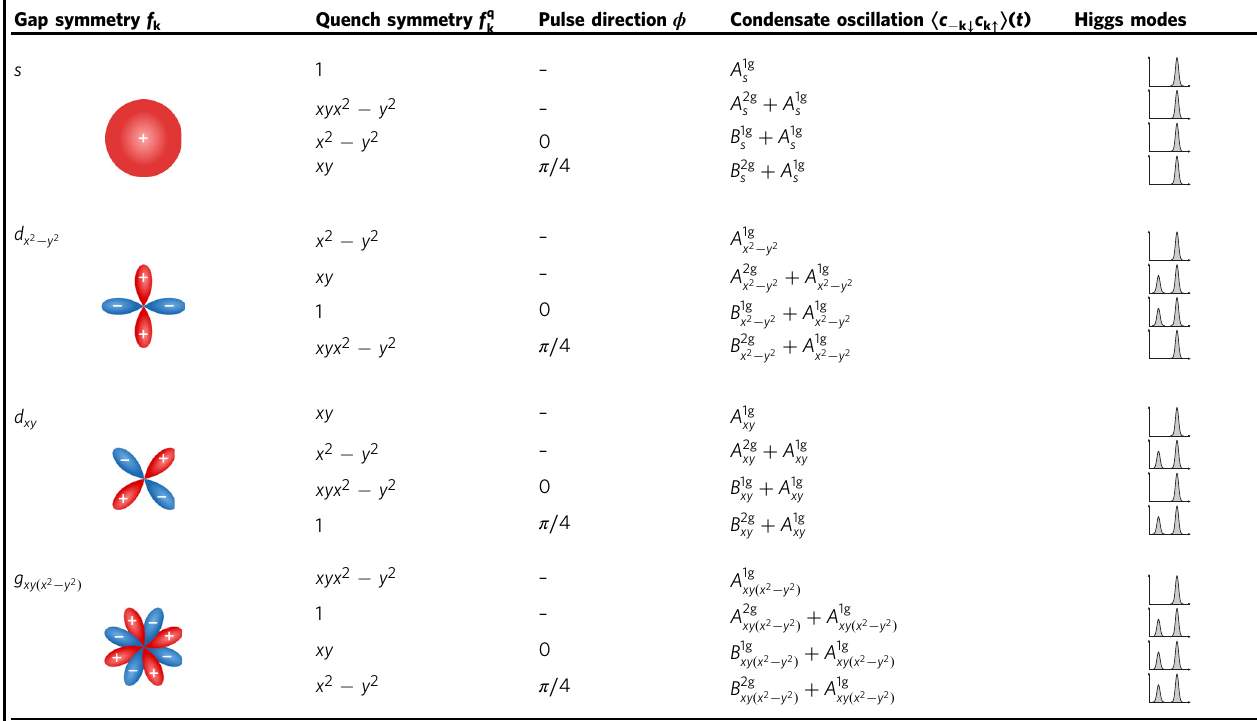
A quench can be applied tothe condensate witha certain symmetry f q k (column two), whichdisturbs the ground state condensate symmetry. These quenches canbe controlledby an incident THz pulse with angle ϕ . Pumping at an arbitrary angle corresponds to a quench in all symmetry channels. Choosing high symmetry direction (column three) allows for a selective excitation. Such a quench excites oscillations of the condensate (column four), classi fi ed by the notation of the irreducible representations of the lattice symmetry. Oscillations of the condensate lead to amplitude oscillations of the gap and the qualitative Fourier spectrum of these Higgs oscillations is illustrated in the last column, showing the possible Higgs modes. An animation on how each quench deforms a given symmetry can be found in the Supplementary Movie 1.